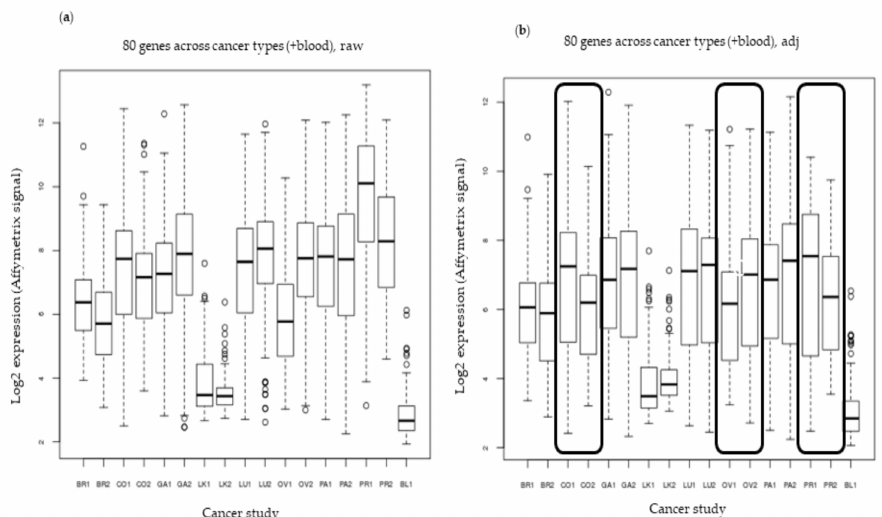
Figure 4. Evaluation of expression of the 80 genes in 17 di ff erent datasets including 8 di ff erent types of cancer. ( a ) Boxplots of the average expression levels of the 80 genes across 17 expression sets without batch correction. ( b ) Boxplots of the average expression levels across 17 expression sets with batch correction. The medians and interquartile ranges of expression in colon, ovarian, and prostate studies, after batch correction, showed di ff erences among the pairs of the same tissue. These di ff erences